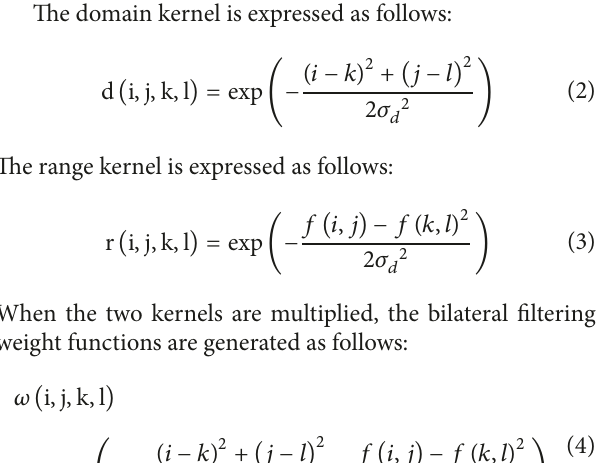
The weighting coefficient 𝜔(𝑖, 𝑗, 𝑘, 𝑙) depends on the kernel product of the domain and